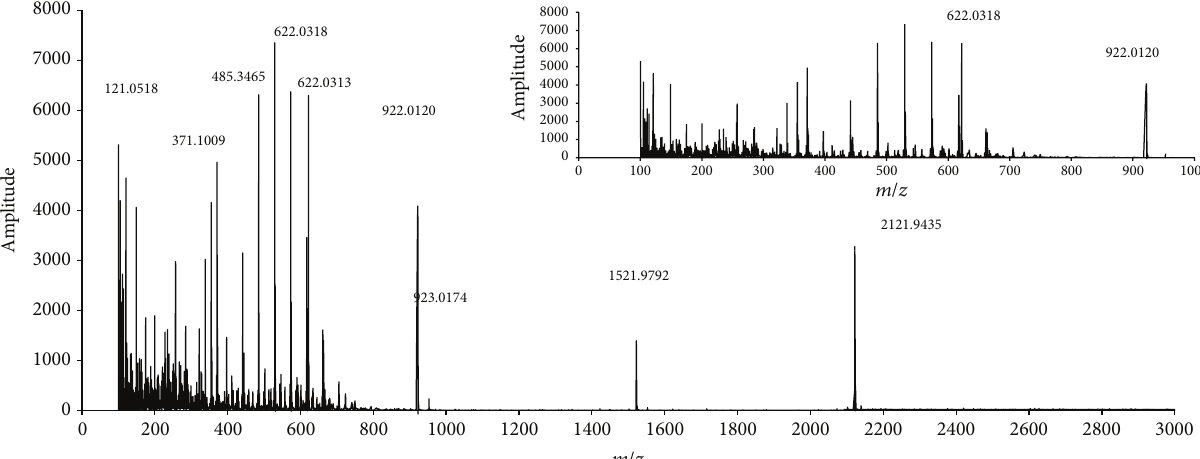
Figure 7: Mass spectrum of the DOM of size less than 0.45 𝜇 m obtained from point 2. Spectrum registered with